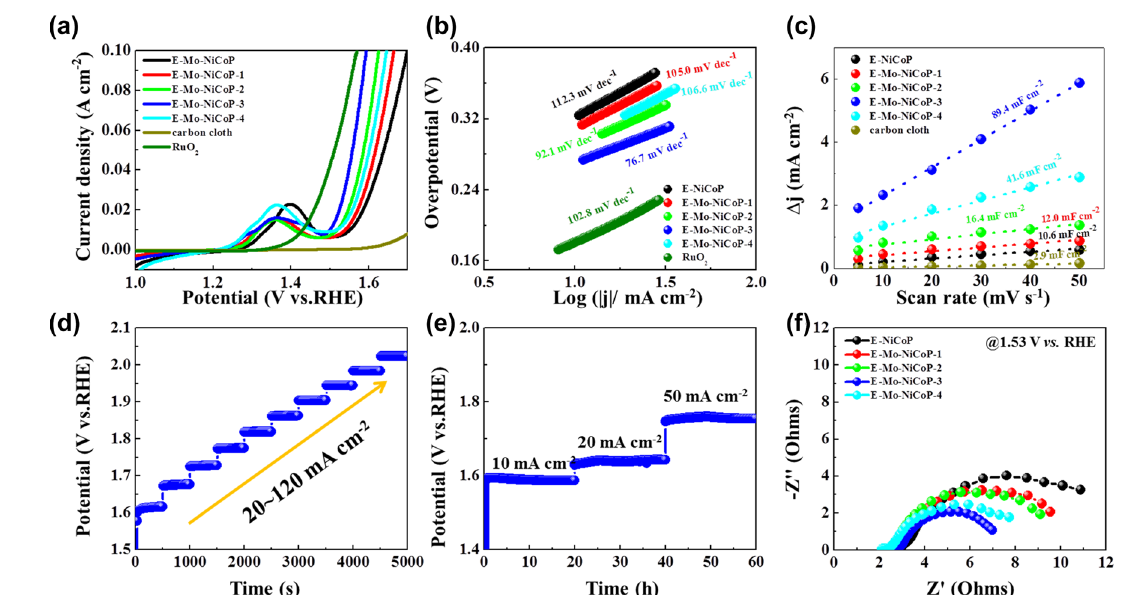
Fig. 4 a Polarization curves, b the corresponding Tafel slope plots, and c the current density against scan rates of obtained samples after elec- trochemical activation. d Consecutive multi-step chronoamperometric tests for E-Mo–NiCoP-3 (without iR correction). e Chronopotentiometry measurements for E-Mo–NiCoP-3 (without iR correction). f The Nyquist plots of obtained samples after electrochemical activation